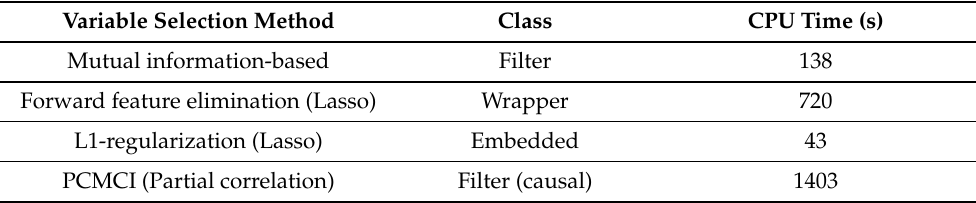
Table 12. CPU times demanded for the variable selection methods that provided the best performance in each class for detection of Faul F-I in the industrial